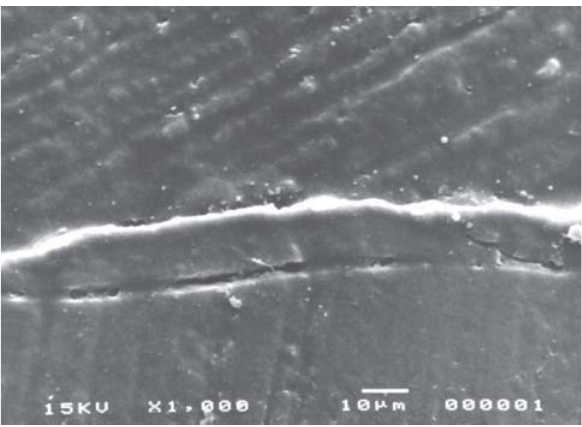
FIGURE 1- Conventional polymerization/microfilled resin composite. Presence of gaps at the axial wall